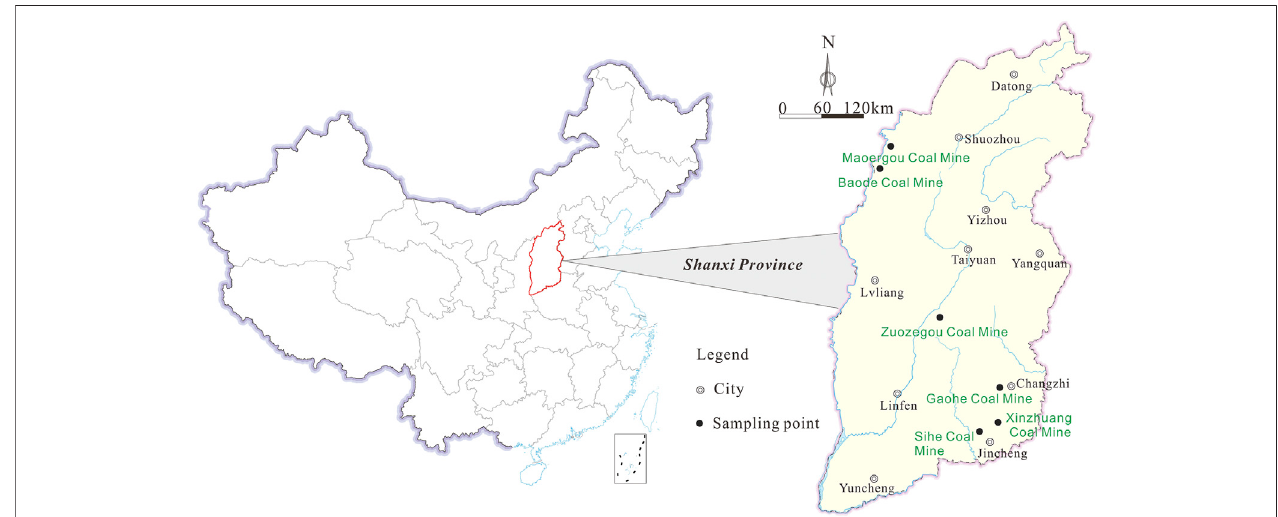
FIGURE 1 | Sampling location in the Shanxi Province.